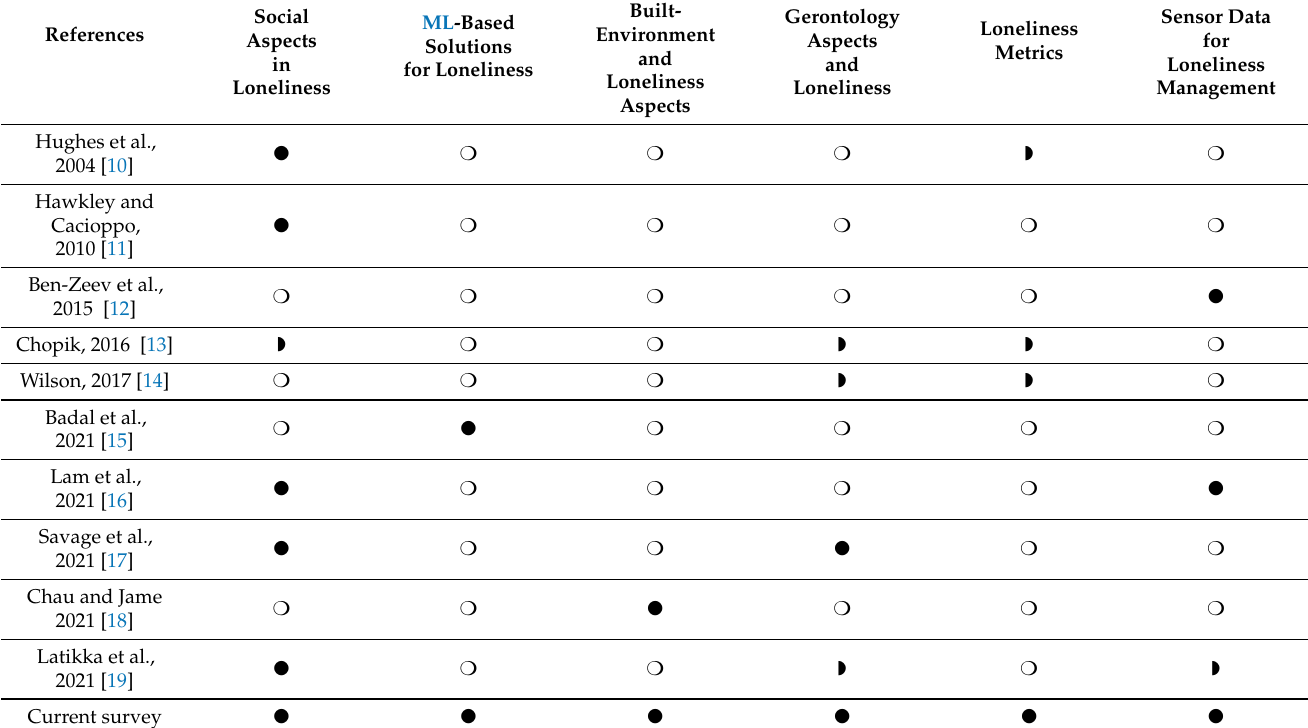
Table 1. Related surveys in the literature and comparison with our